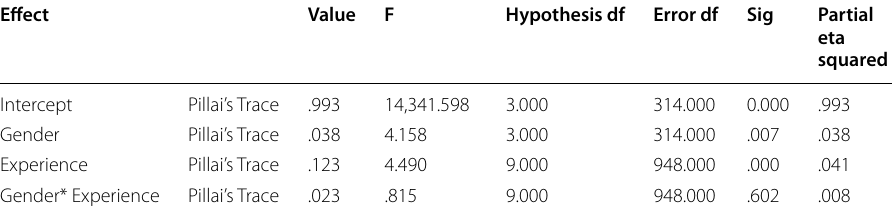
M Mean, SD = Table.3 Multivariate tests of gender and teaching experience